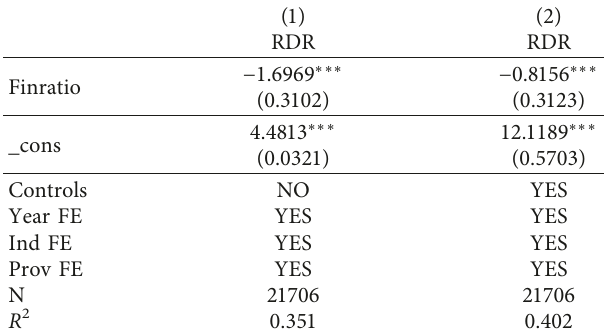
Table 7: Competition